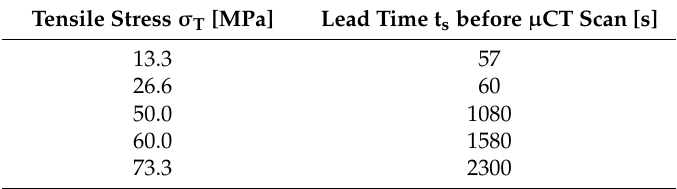
Table 1. Lead time before starting a µCT scan at different tensile loads to avoid formation of image artifacts.